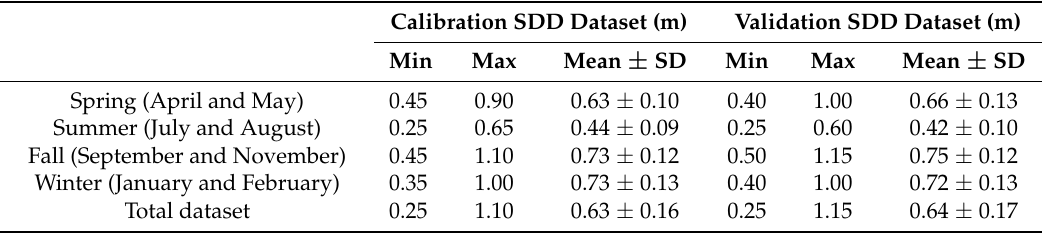
Table 1. Statistics of the in situ water Secchi disk depth (SDD) for calibration and validation in Lake